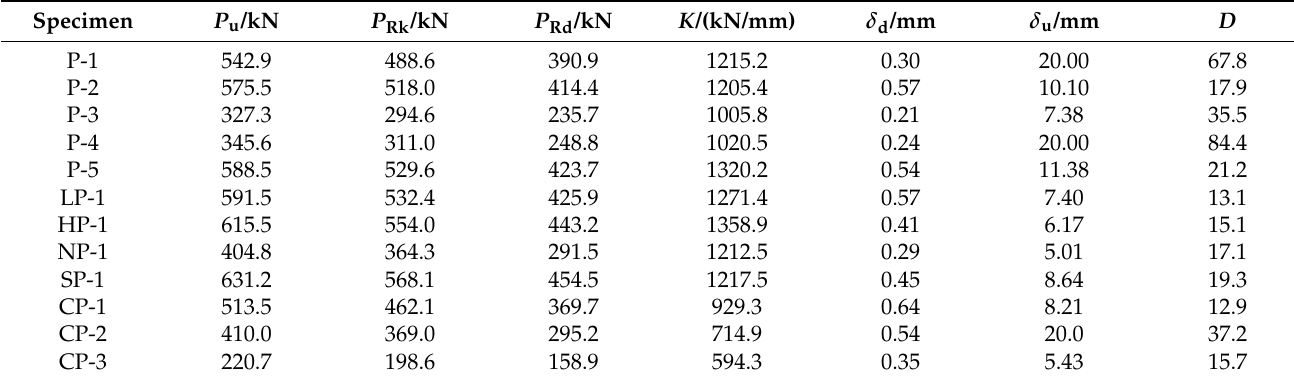
Table 4. Static performance indicators of perfobond